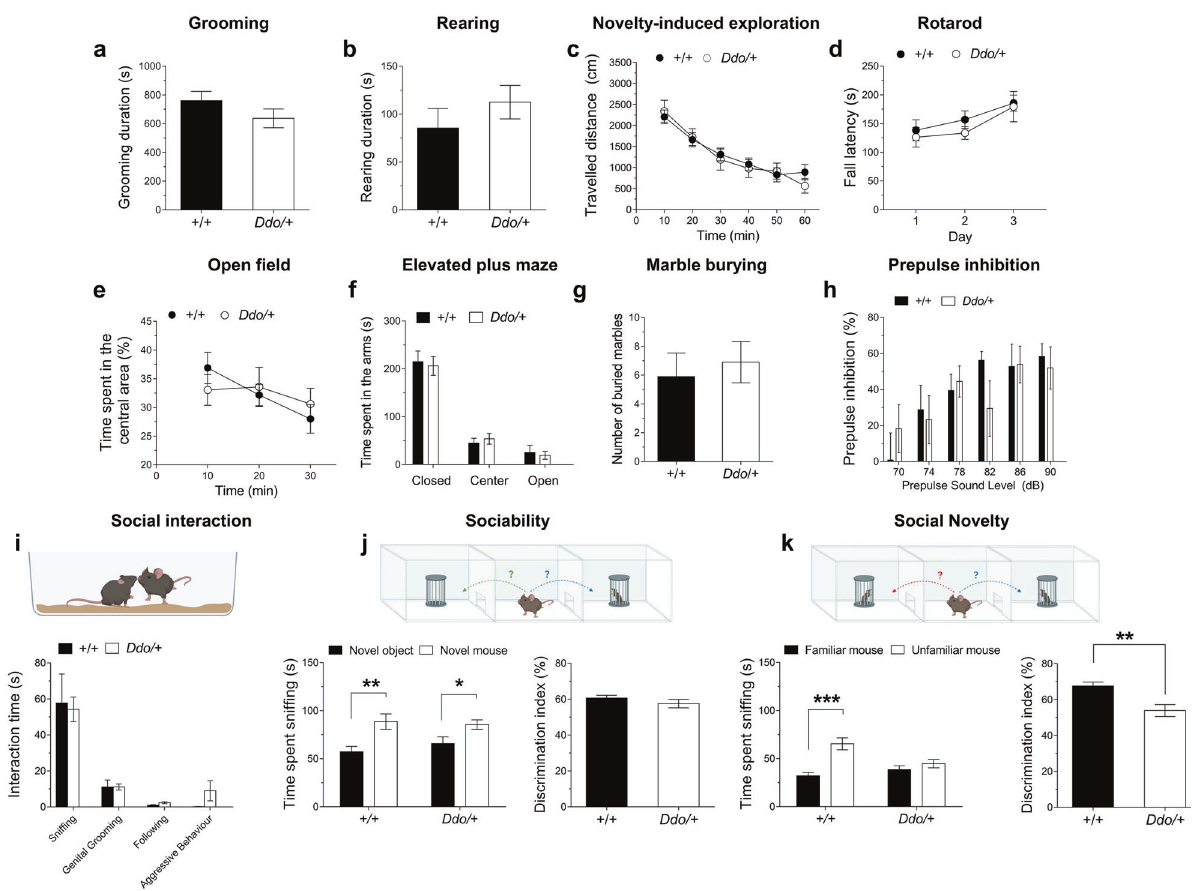
Fig. 2 Ddo-overexpressing mice exhibit selective social recognition de fi cit. a – k R26 Ddo/ + and R26 + / + mice were tested in a series of behavioral tasks relevant to psychiatric phenotypes. a , b Analysis of grooming and rearing (duration, expressed in s; n = 8/genotype), ( c ) novelty-induced exploration test (traveled distance; expressed in cm, n = 15/genotype), ( d ) rotarod test (fall latency, expressed in s; n = 8/ genotype), ( e ) open fi eld test [time spent in the central area, expressed as percentage (%) of total time (peripheral + central area); n = 8/ genotype], ( f ) elevated plus-maze test (time spent in the arms, expressed in s; n = 10/genotype), ( g ) marble burying test (expressed as number of buried murbles; n = 10/genotype), ( h ) prepulse inhibition of the startle re fl ex [expressed as percentage (%); n = 8/genotype], ( i ) social interaction (interaction time, expressed in s; n = 8/genotype), ( j ) sociability and ( k ) social novelty test ( n = 14/genotype). j , k Sociability and social novelty tests were analyzed as both time spent snif fi ng (expressed as s, left graphs) and discrimination index [expressed as the ratio between the time spent exploring the novel stimulus and the total exploration time, according to the following formulas: (i) sociability test: (time spent with mouse)/(time spent with mouse + time spent with object); (ii) social novelty test: (time spent with novel mouse)/(time spent with novel mouse + time spent with familiar mouse), right graphs]. i – k Representative drawings of the social behavior tasks are shown above graphs. All data are expressed as mean ± SEM. * p < 0.05; ** p < 0.01, compared with novel object; *** p < 0.0001, compared with familiar mouse (Fisher ’ s post hoc